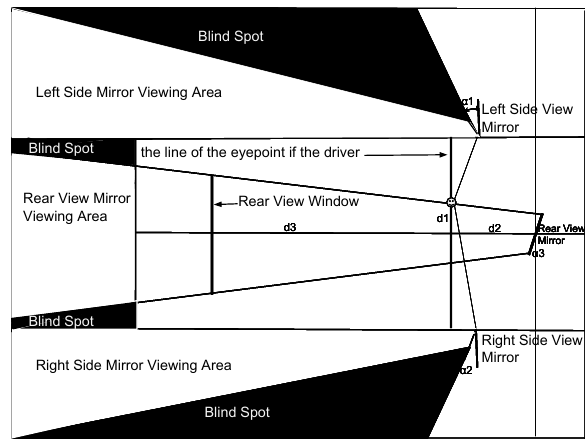
Figure 2. The geometric model used to simulate the blind spots in the lane change simulator. In this case, the mirrors are in the optimal arrangements for the minimization of the size of blind